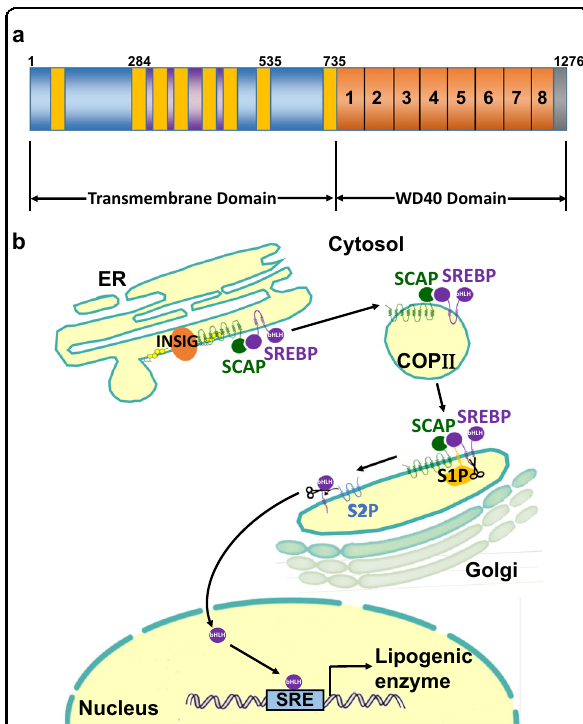
Fig. 1 Schematic model of the domain organization and processing mechanism of SCAP. a SCAP proteins consist of an amino-terminal domain of eight transmembrane helices and a carboxyl-terminal WD40 domain. Transmembrane helices 2-6 of SCAP constitute a sterol-sensing domain. b When mammalian cells are deprived of cholesterol, SCAP escorts SREBPs in COPII vesicles from the ER to the Golgi. Two Golgi proteases (S1P and S2P) then sequentially cleave SREBPs. The NH 2 -terminal region of SREBPs moves to the nucleus and activates the transcription of target genes. To date, SREBPs are known to directly enhance the transcription of more than 30 genes needed for the uptake and synthesis of cholesterol, fatty acids, triglycerides, and phospholipids. Despite acting in diverse biosynthetic pathways, the activity of each SREBP isoform is regulated by sterols and SCAP. COPII, coat protein II; ER, endoplasmic reticulum; INSIG, insulin-induced gene; S1P, site-1 protease; S2P, site-2 protease; SCAP, SREBP cleavage-activating protein; SRE, sterol regulatory element; SREBP, Sterol regulatory element-binding